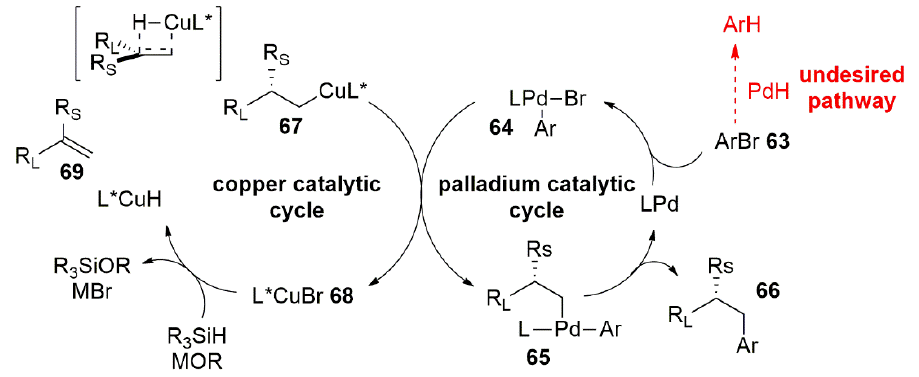
Figure 30 . Proposed catalytic cycle of reaction in Figure 29b.